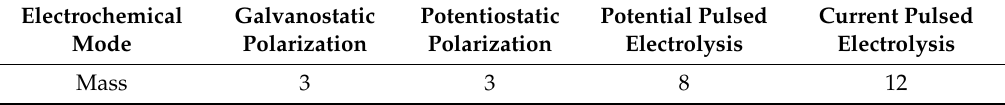
Table 1. The mass of the deposit (in mg) for each electrochemical test